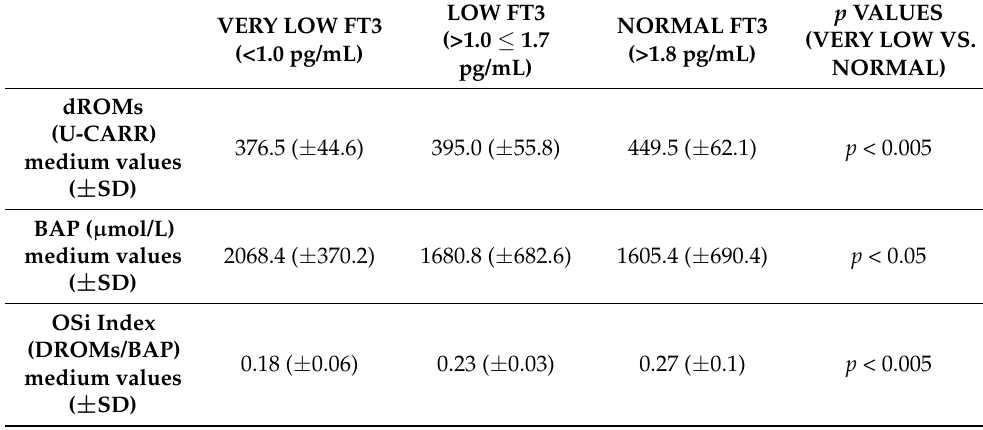
Table 3. Oxidative Stress in COVID-19 patients with and w/o